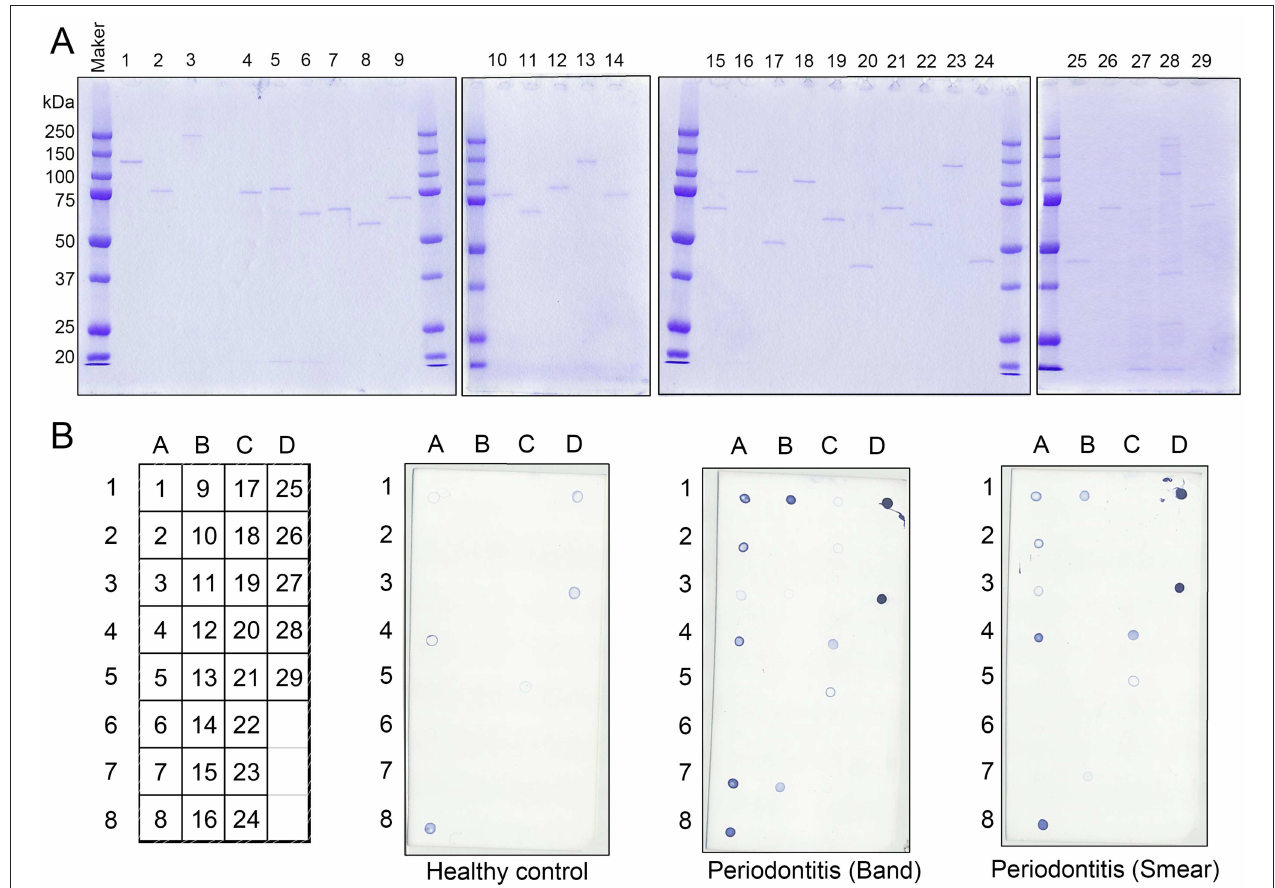
Table 2 . Approximately, 50 ng of each recombinant protein was loaded into each lane. (B) Serum IgG responses to the recombinant proteins by dot blot analysis with mixed serum used in the immunoaffinity columns (clear bands, smears, and healthy individuals). Approximately, 50 ng of each protein was blotted on the membrane, and sera were used at a dilution of 1:2,500. The left panel shows a scheme of the proteins spotted on the membrane. The numbers exhibited on the left panel are the recombinant protein numbers shown in Table 2 .